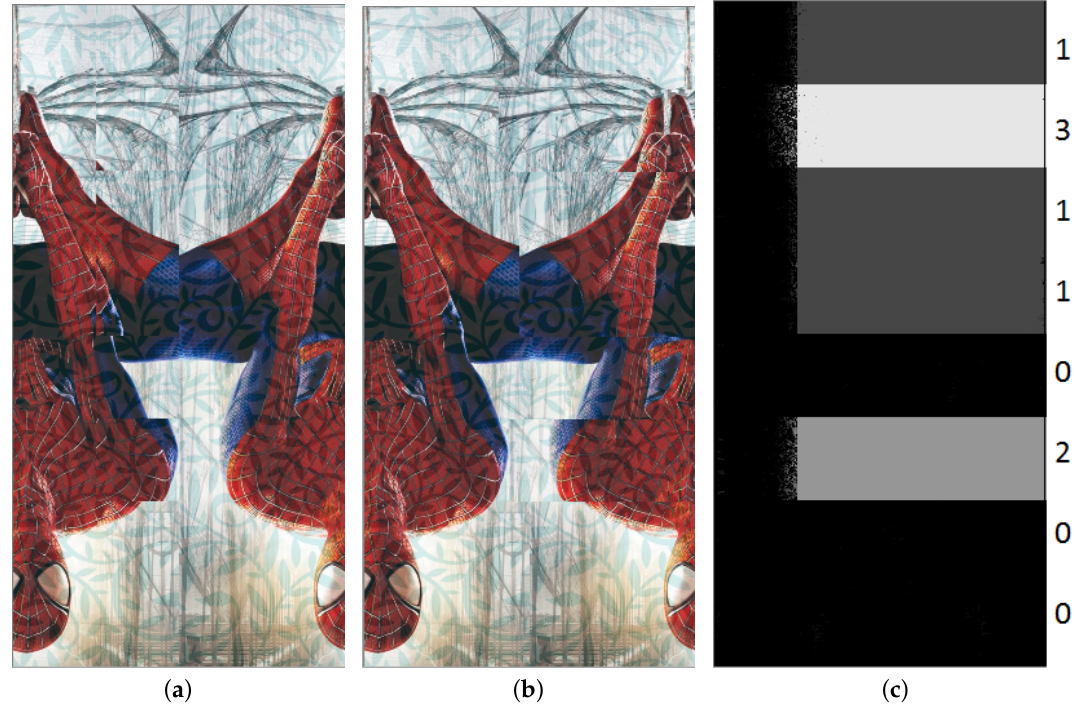
Figure 11. Left and right stereo images extracted from the Spider-Man tag shown in Figure 9b and its disparity map, read from top down: 13,110,200 4 = 29,984 10 . ( a ) left stereo image; ( b ) right stereo image; ( c ) resulted disparity.